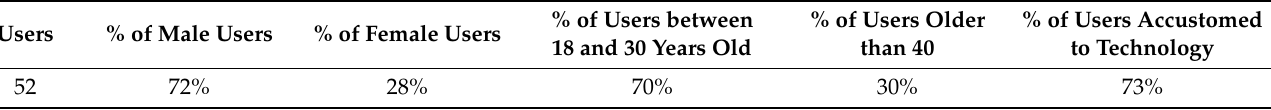
Table 1. User demographic information.